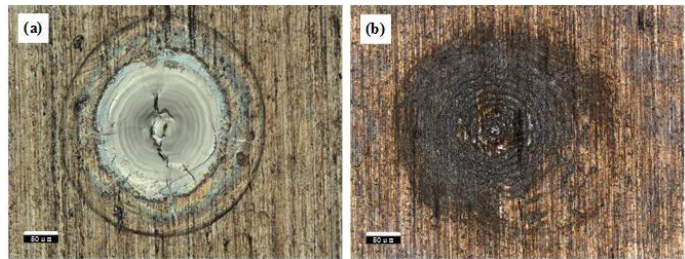
Figure 2. The ablation morphology under different pulse width laser ( a ) ms pulse laser ( b ) ns pulse laser.